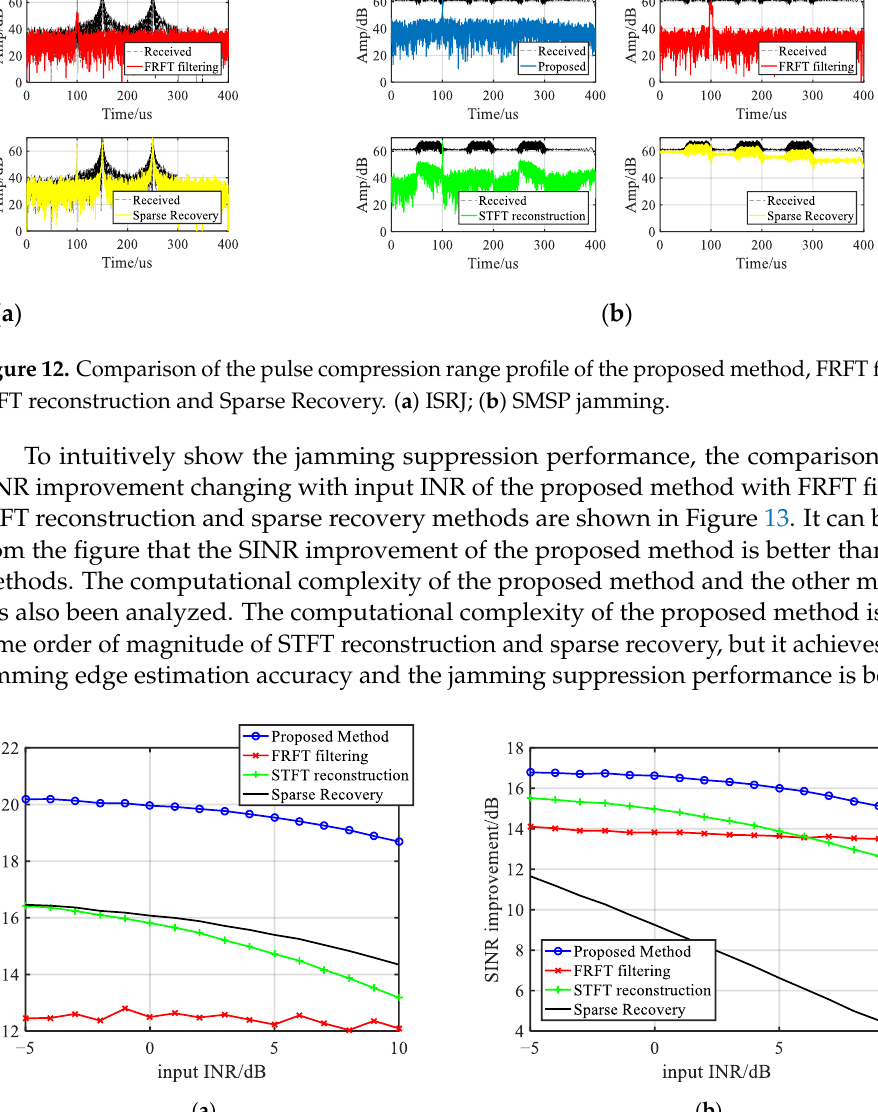
Table 2. Computational complexity comparison of various methods. Method